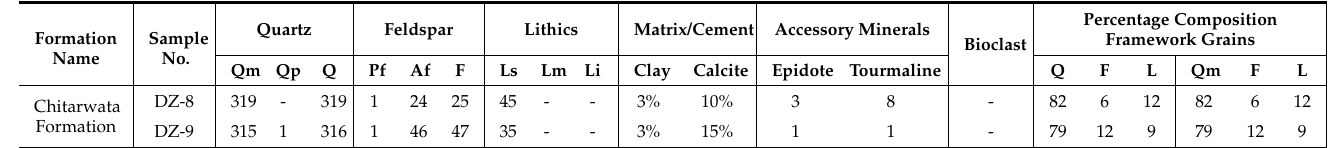
Table 1. Petrographic data of studied samples and percentage compositions of the framework grains. Where, Qm—monocrystalline quartz, Qp—quartz polycrystalline, Pf—plagioclase feldspar, Af— alkali feldspar, F—total feldspar, Ls—sedimentary lithics, Lm—metamorphic lithics, Li—igneous lithics, L—total lithics, and Q—total quartz.